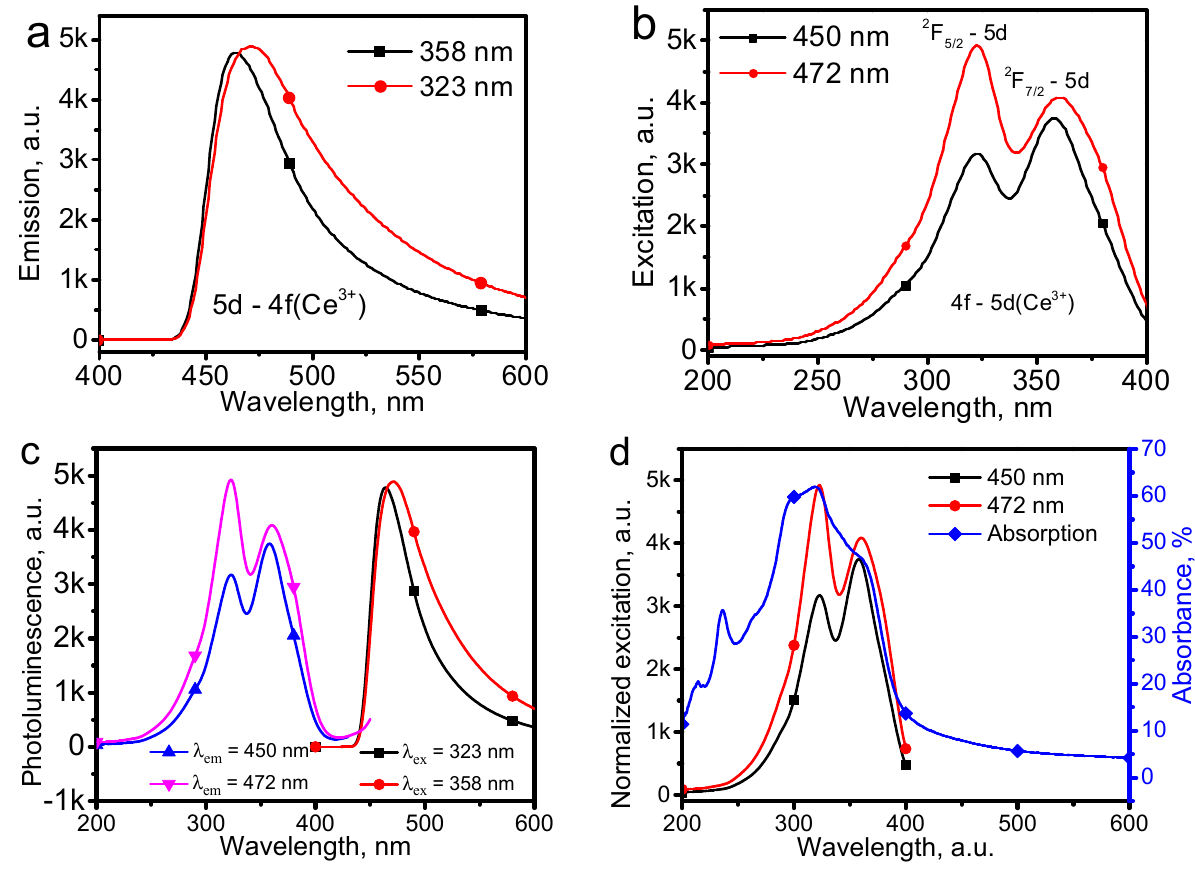
Figure 5. The emission, excitation, and absorption spectra of the CeSc 3 (BO 3 ) 4 host. ( a ) Emission, ( b ) excitation, ( c ) plotting emission and excitation together, ( d ) plotting excitation and absorption together.